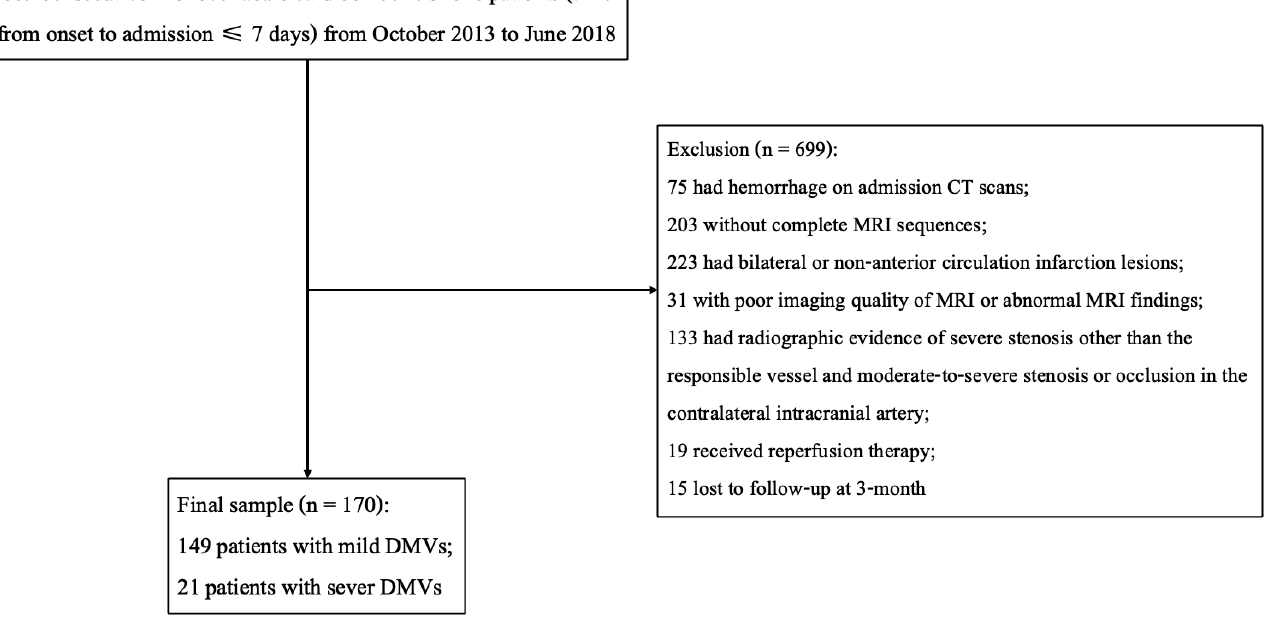
Figure 2. Flow chart of patient enrollment.